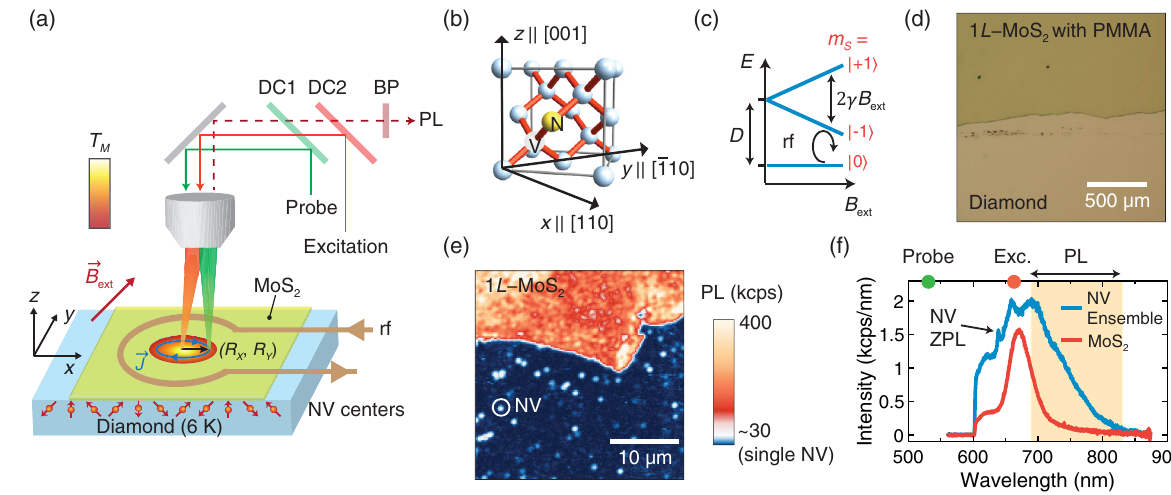
FIG. 1. Mapping photocurrents in monolayer MoS 2 with NV centers. (a) Experimental setup. A monolayer MoS 2 sheet is transferred onto a diamond sample hosting a near-surface ensemble of NV centers. An excitation laser (661 nm) generates a ⃗ J . The NV center senses the local temperature distribution T M within MoS 2 that drives a circulating photocurrent distribution magnetic field produced by the photocurrents and is optically read out by a separate probe laser (532 nm). DC1/DC2 — dichroic mirrors at 550 = 685 nm; BP — bandpass (690 – 830 nm). (b) NV center in the diamond lattice. We address the subset of NV centers aligned with the [111] direction. (c) Energy levels of the NV spin triplet as a function of B , the magnetic field parallel to the ext NV axis. Resonant microwave pulses (rf) manipulate an equal superposition of the m s ¼ j 0 i and j − 1 i states for phase acquisition. D — zero-field splitting. (d) Optical micrograph of monolayer MoS 2 on diamond after vacuum transfer. To enhance optical contrast, this micrograph is taken prior to cleaning off a poly(methyl methacrylate) (PMMA) support layer. (e) Room-temperature PL image of the boundary between monolayer MoS 2 and bare diamond, containing single NV centers. (f) Room-temperature PL spectrum of monolayer MoS 2 and an ensemble NV sample under 532-nm illumination. The photoexcitation wavelength (661 nm) is longer than the NV zero-phonon line (ZPL; 637 nm) to minimize optical excitation of the NV center. The orange shaded region depicts the collected PL for NV spin